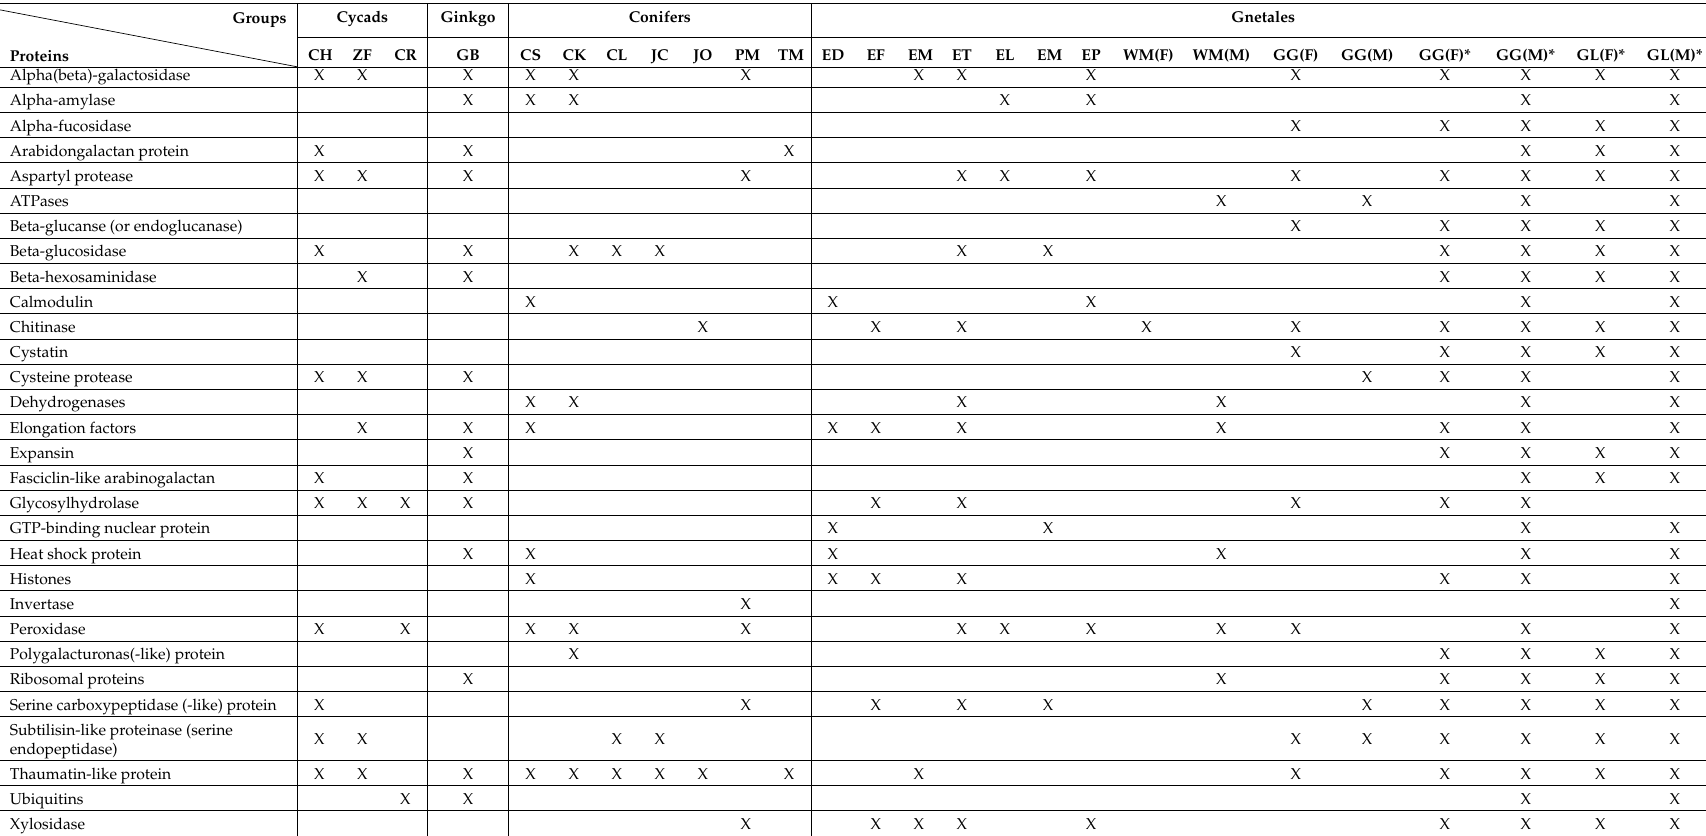
Table 1. Thirtycommonly seen proteins identified in the pollination drops of